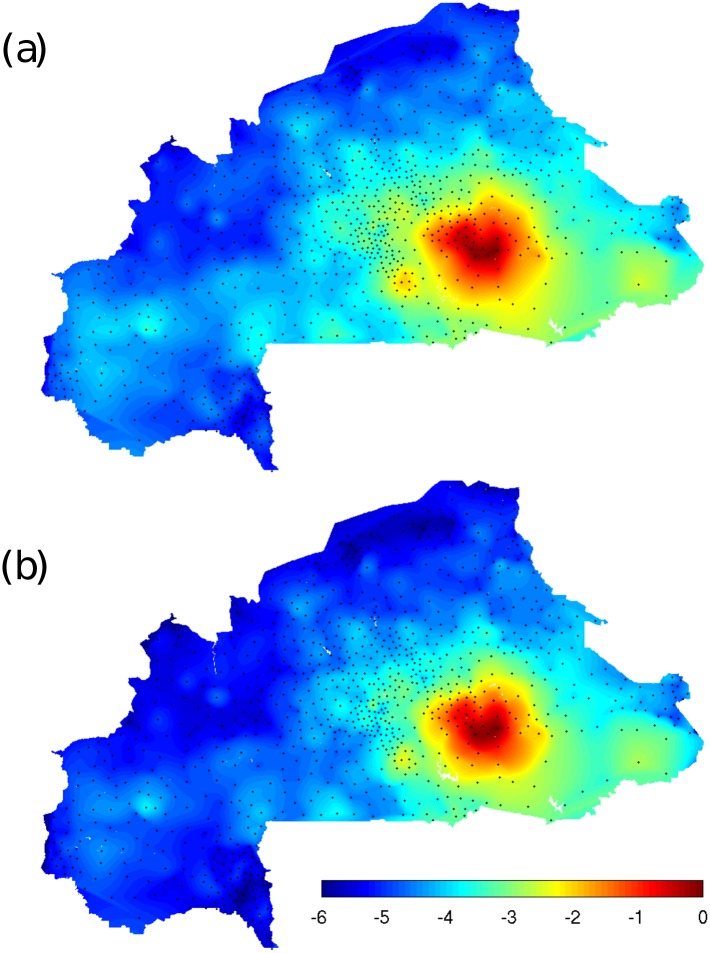
Eigenvector analysis as predictive tool.Comparison of the equilibrium state of the system for a 1′000 node aggregated network for the parameter set {α = 0.01, θ
MAX = 0.31, m = 0.4}. (a) Spatial distribution of disease intensity at the equilibrium expressed as a linear interpolation of mean worm burden W
i at the aggregated network nodes (black dots) in log10-scale. (b) Spatial patterns of disease spread predicted by the rescaled dominant eigenvector g0 of the system at the transcritical bifurcation of the DFE in log10-scale.